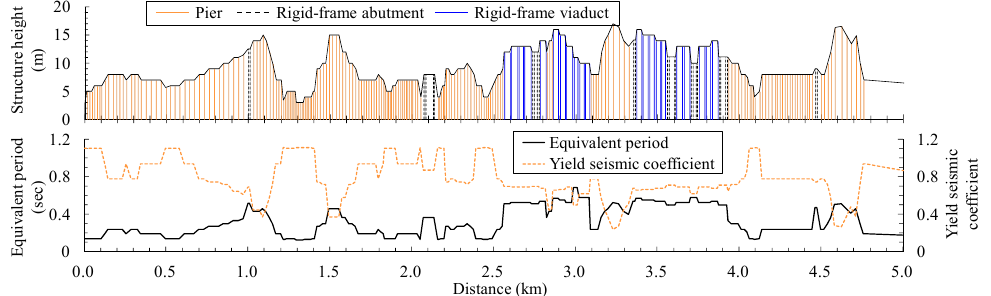
Figure 1. Specifications of entire model line.